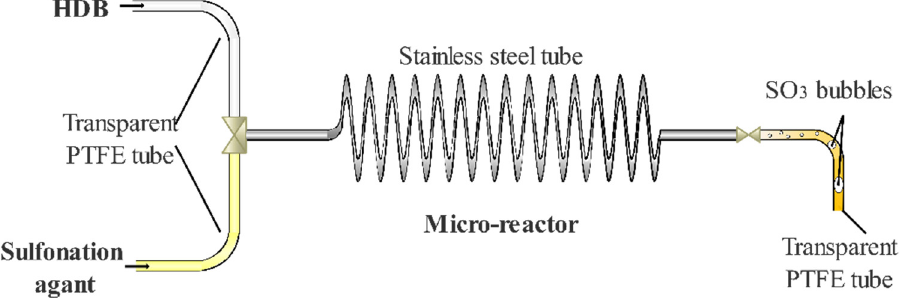
Figure 5: Schematic of the reactor